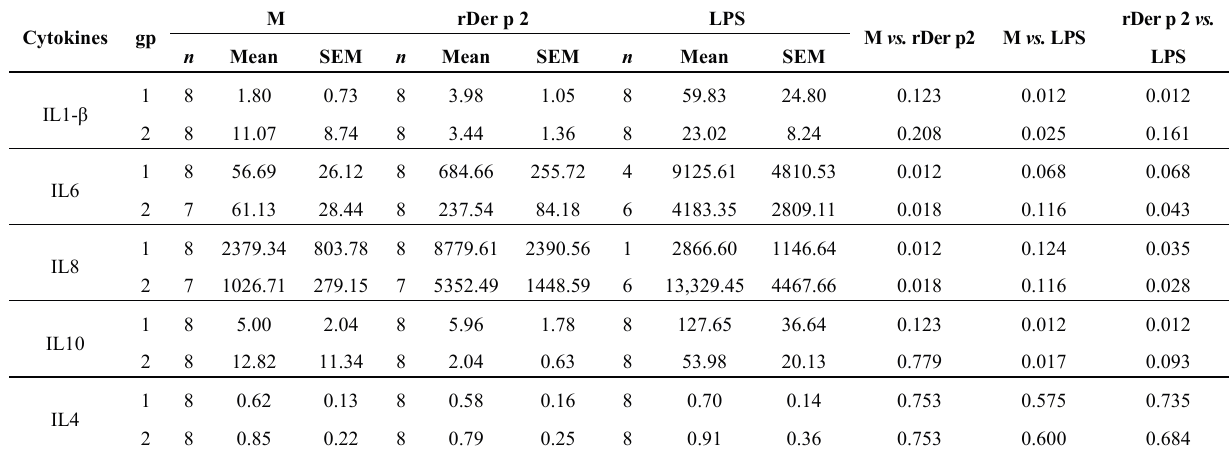
Table 4. Comparison of cytokine secretion derived from PBMC after culture with or without Der p